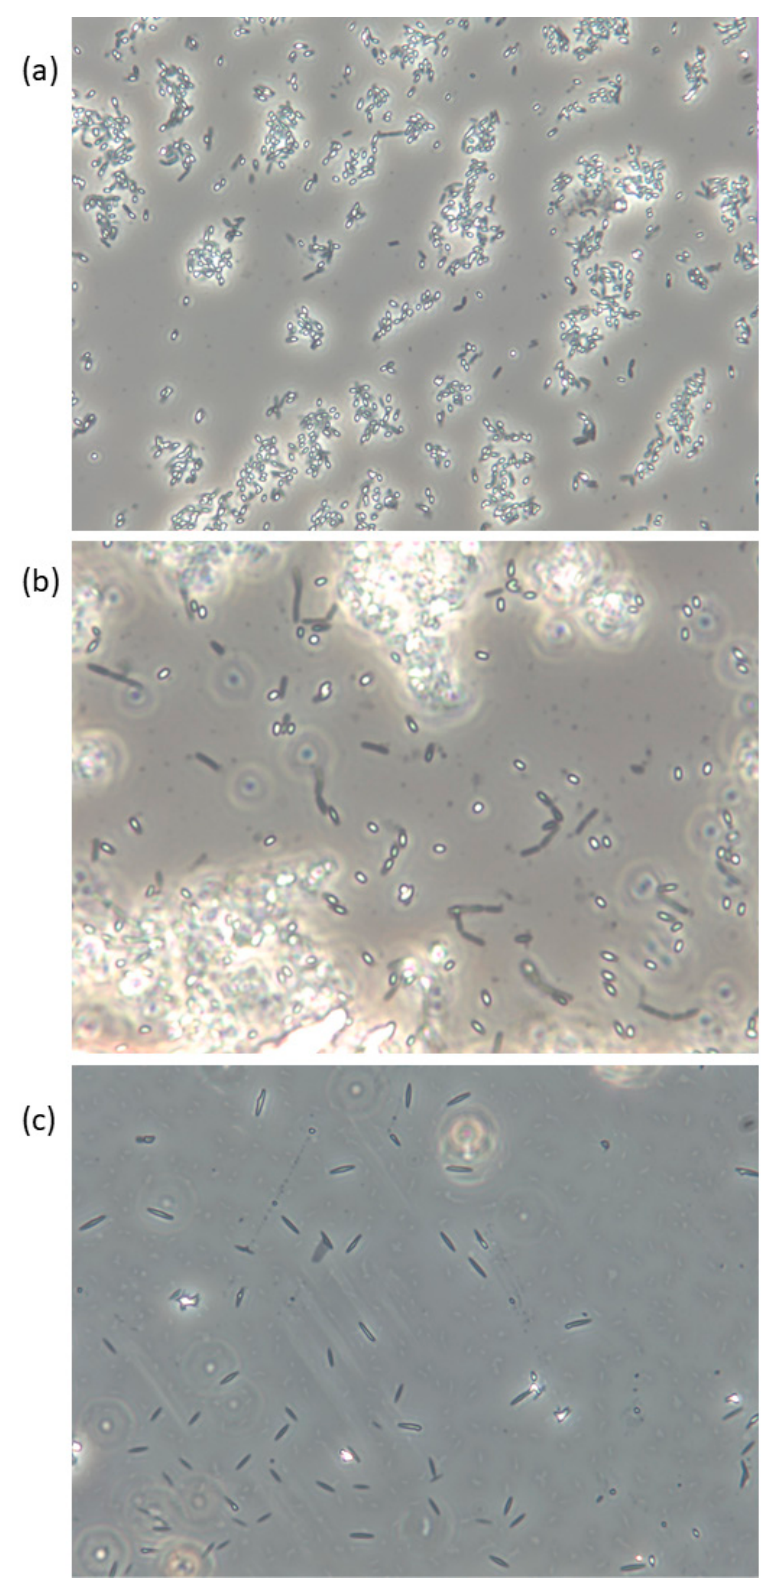
Figure 1. Live phase-contrast microscopy images of ( a ) B. licheniformis , ( b ) B. pumilus , and ( c ) B. subtilis isolated from Saccharina latissima and cultivated on Marine Agar. Spores appear white/bright and vegetative cells are dark. Magnification: 400 ×